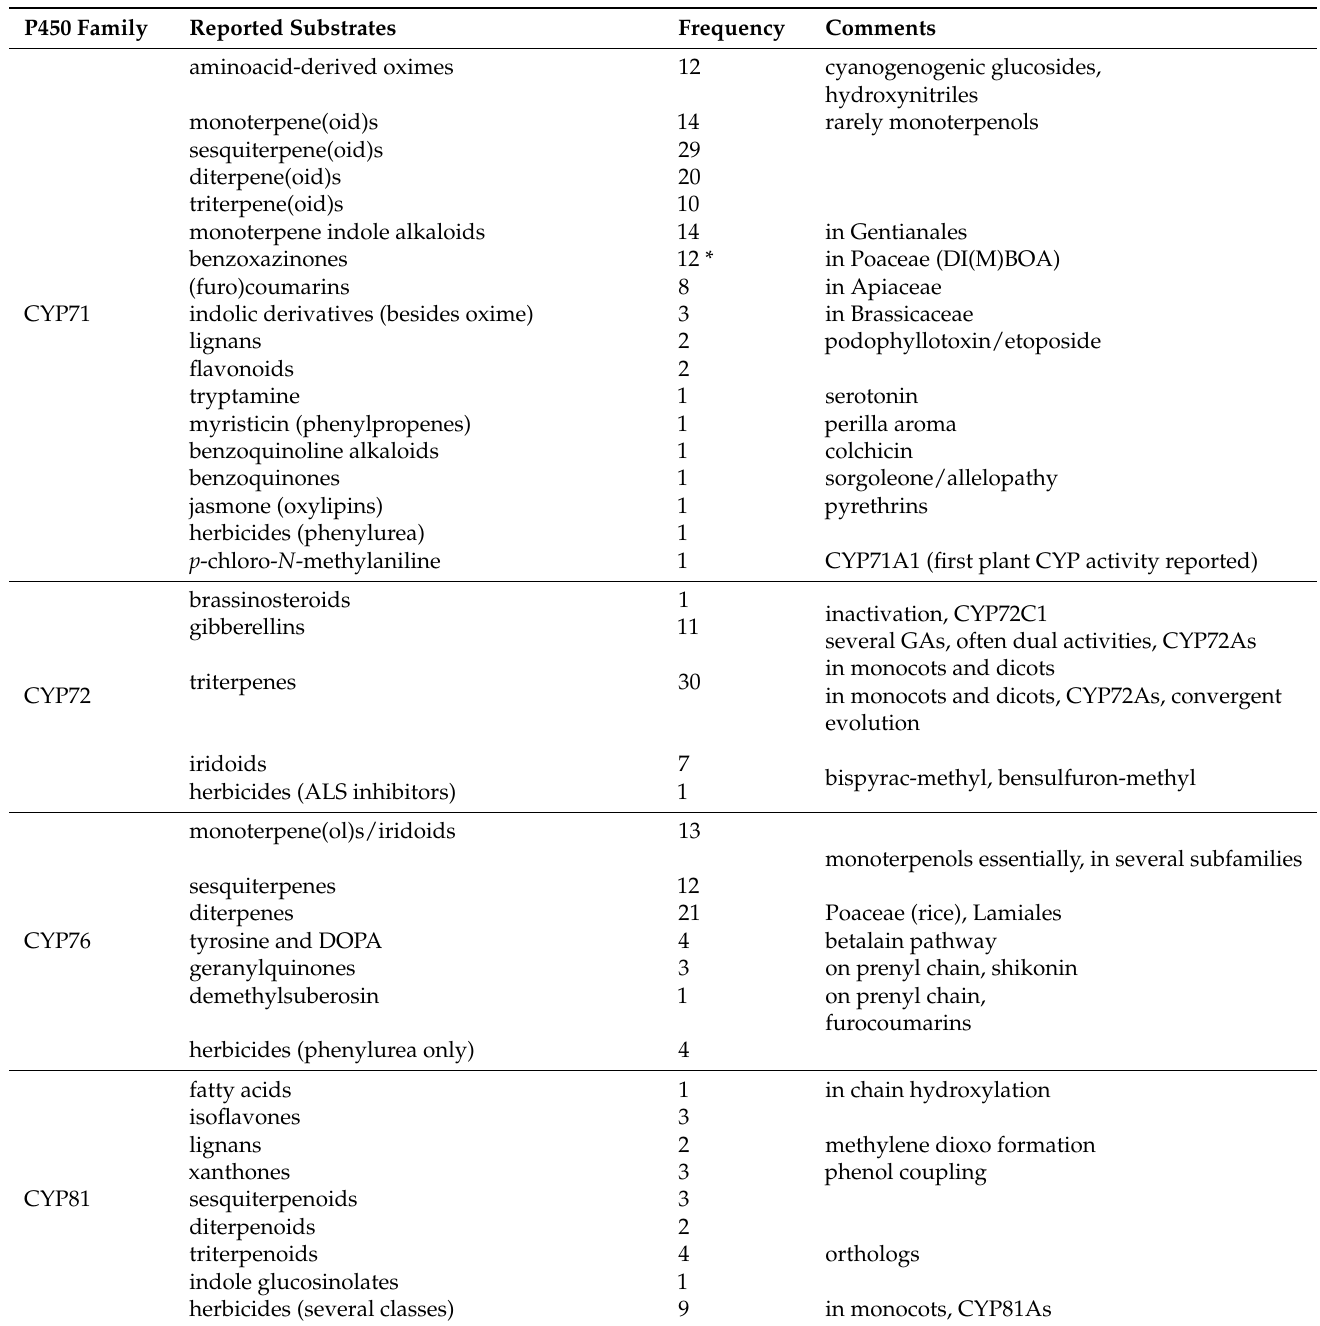
Table 1. Catalytic activities reported for the most diversified (blooming) plant CYP families. Fre- quency refers to the number of enzymes investigated and shown to metabolize a class of compounds. N.B. the table is exclusively based on the currently available erda.dk/public/vgrid/PlantP450/ database that is focused on plant physiological activities, but not exhaustive regarding metabolism of xenobiotics. The database will be updated in the coming months in this respect. References of the publications reporting activities of the members of each family can be found in the